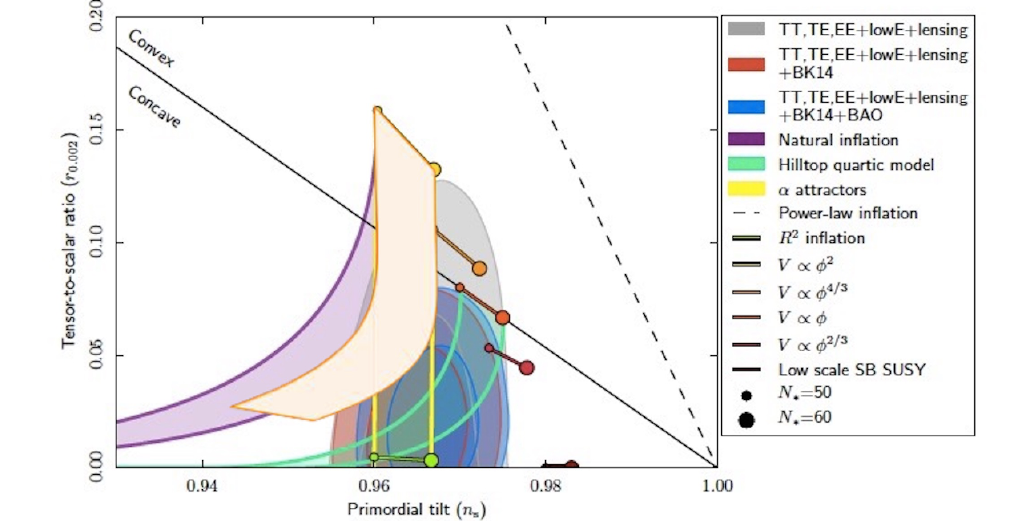
Figure 12 . ( n s ; r )-plane for various in(cid:13)ationary models (taken from [7]) with the predictions for the back-reacted natural in(cid:13)ation model superimposed through the orange strip, for parameter choice (cid:3) s = (cid:22) = 10 (cid:21) = (cid:20) = 2 M = 10 16 GeV and log ( f (cid:24) =M Pl ) within the prior [0 : 57 ; 2 : 55]. 10 . f . 350 M 3 : 5 M . Taking into account the back-reaction from the in(cid:13)adrons in case Pl (cid:24) Pl